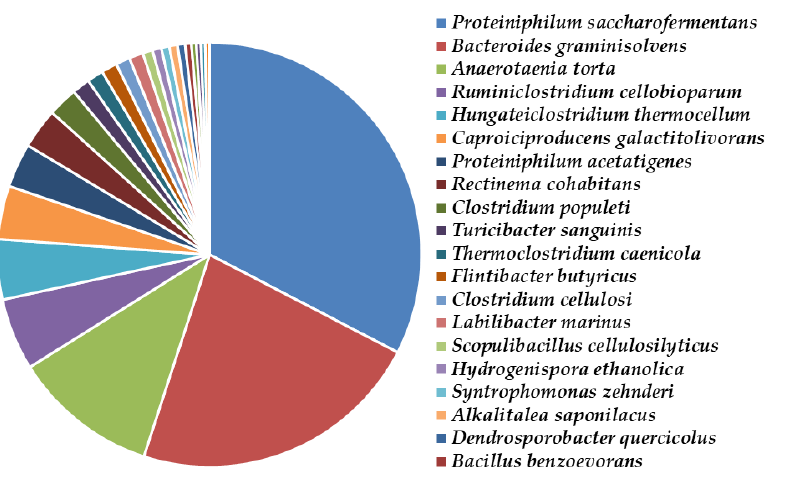
Figure 11. Species diversity in the methane-producing microbial consortium inhabiting the second bioreactor.